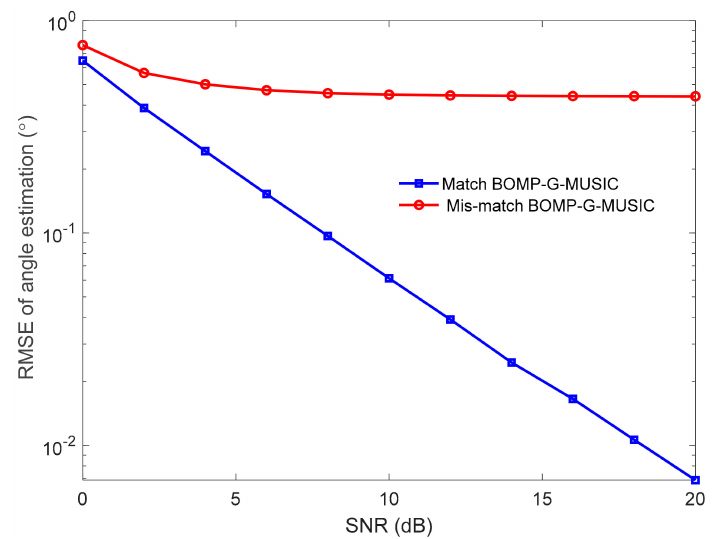
Figure 7. Low elevation estimation RMSE for terrain mismatch and matching.